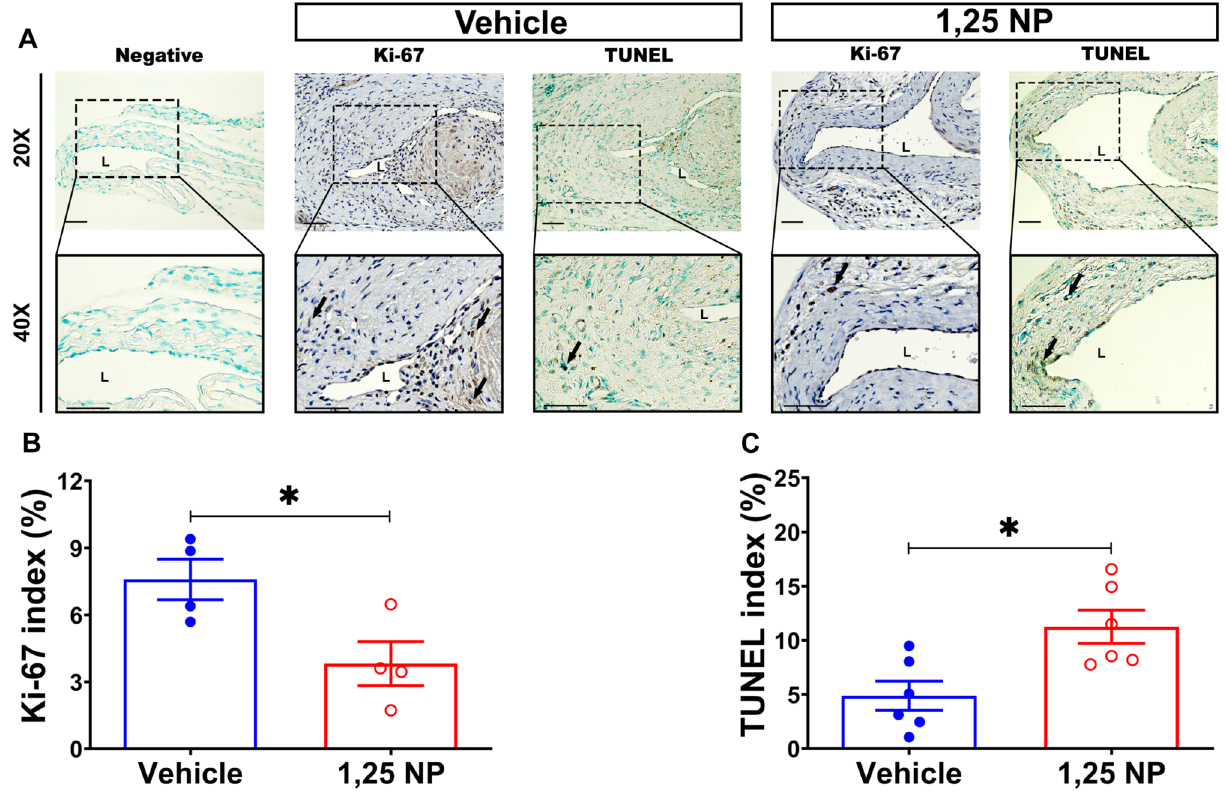
Figure 7. Proliferation and apoptosis staining in 1,25 NP treated vessels. ( A ) Representative slides for negative control, Ki-67 and TUNEL staining. There is more proliferation and less apoptosis in the vehicle controls compared to 1,25 NP treated vessels. ( B , C ) Semi-quantitative analysis demonstrated a significant decrease in the average Ki-67 index ( p < 0.05) and increase in the average TUNEL index ( p < 0.05) in 1,25 NP treated vessels compared to vehicle controls. Each data point in the scatter plot bar graph represents the mean ± SEM of 4–6 AVF mice. Unpaired t- test was performed. Significant differences are indicated * p < 0.05. ( A ) Positive staining is brown color. L lumen; black arrows indicate positive cells. Scale bar is 50